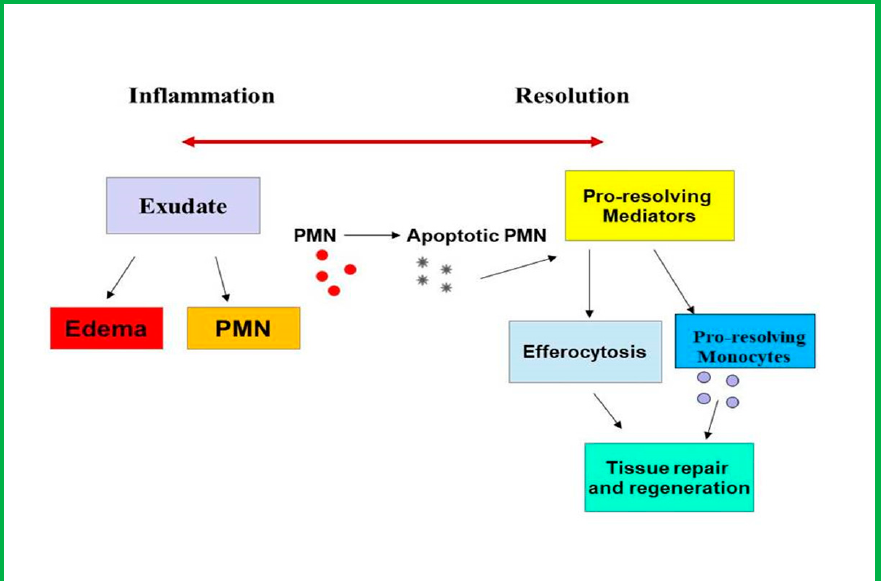
Figure 4. Simplified scheme of biochemical transition from inflammation to resolution. Pro-resolving lipid mediators enhance the clearance (efferocytosis) of apoptotic PNM by macrophages, blocking leukocyte recruitment and favoring tissue repair. PNM (circle in red colour): polymorphonuclear neutrophils; PNM (in gray colour):apoptotic polymorphonuclear neutrophils; stars in blue color: pro-resolving monocytes.